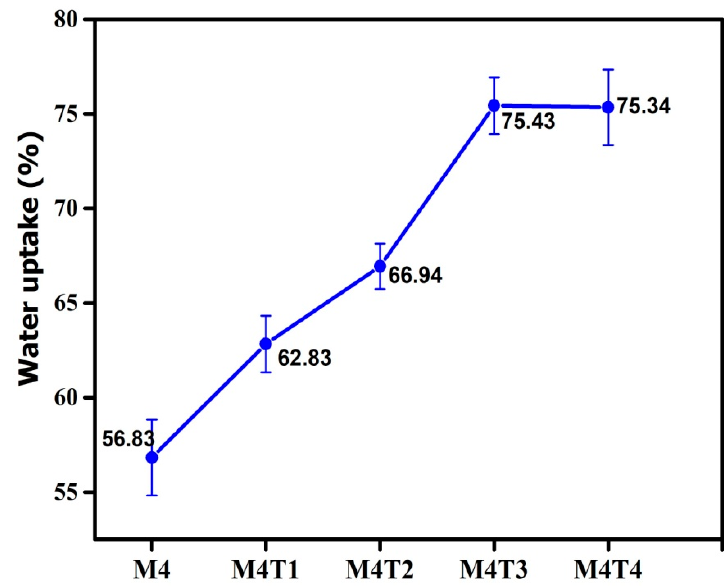
Figure 7. Effect of water uptake on MMNMs and the pristine membrane.